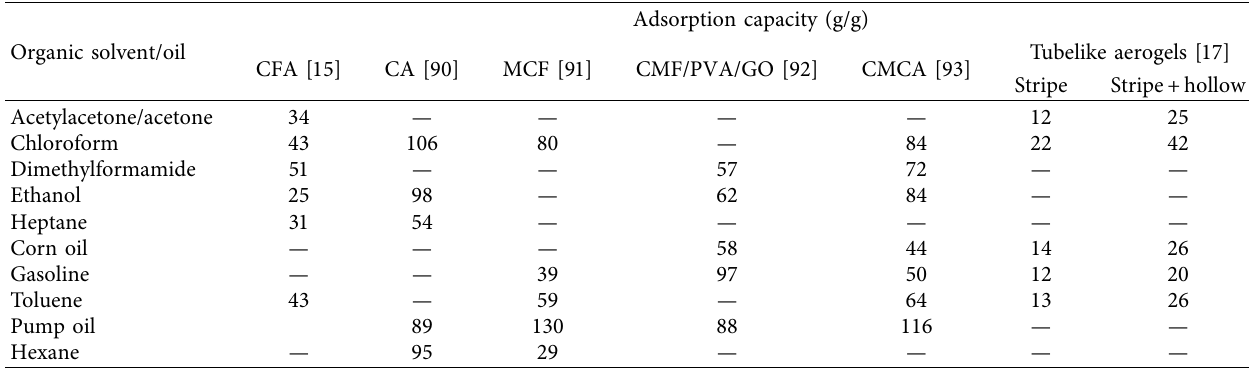
Table 3: Some adsorption capacity for the removal of different organic solvents and oils. Organic